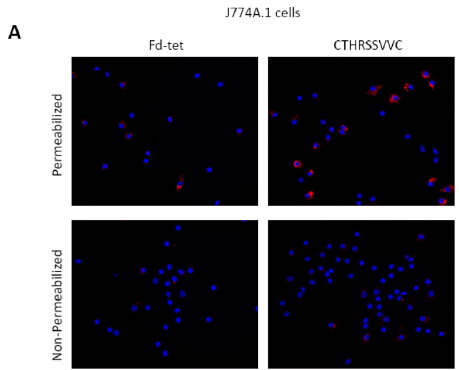
Figure 5 . YES Hypothesis in situ. Fifth Scavenger Receptor domain of CD163 probably is pseudo-homodimer with CTHRSSVVC peptide (CD163-mimic). 2.5. CTHRSSVVC-Phage Is Internalized by CD163 Expressing